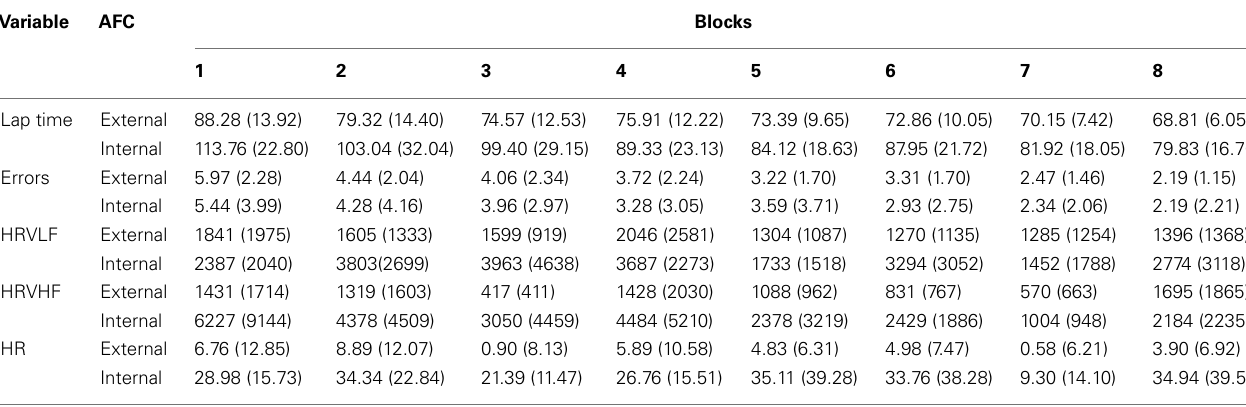
Table 1 | Means ( ± SD) for performance and cardiac variables for practice.